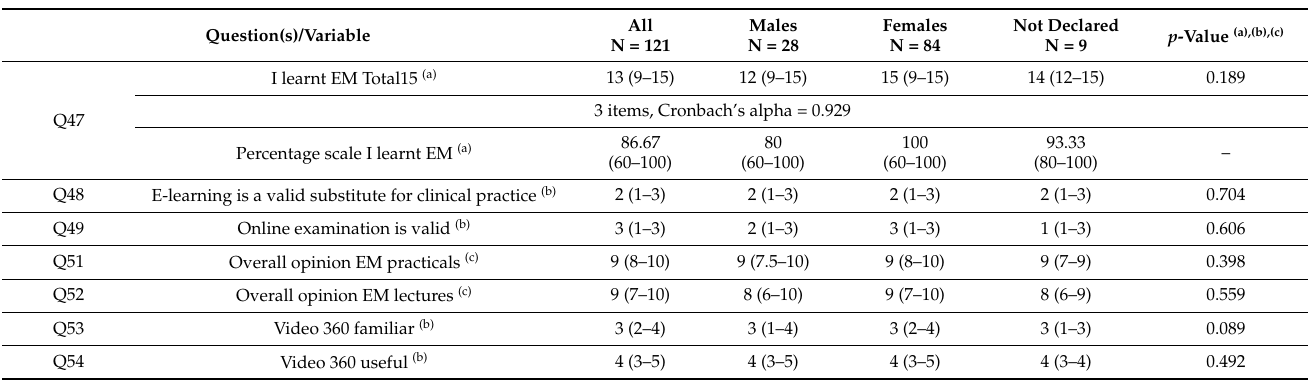
Table 2. Opinions of the ongoing EM course, including separate appraisals for lectures, practical activities and 360-degree video scenarios employed as online educational